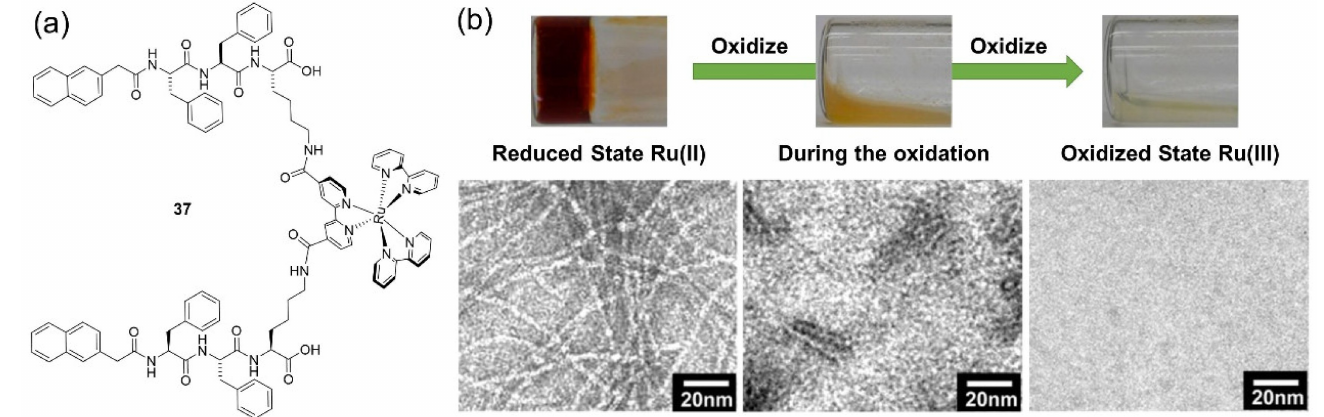
Figure 15. ( a ) Molecular structures of the metallohydrogelator 37 . ( b ) Optical images of oxidation- induced gel − sol transition and TEM images corresponding to the samples at different states of transition. The hydrogel (reduced state) was formed by 0.8% ( w / v ) 37 in water at pH = 1. Reprinted with permission from Ref. [69]. Copyright (2013), American Chemical